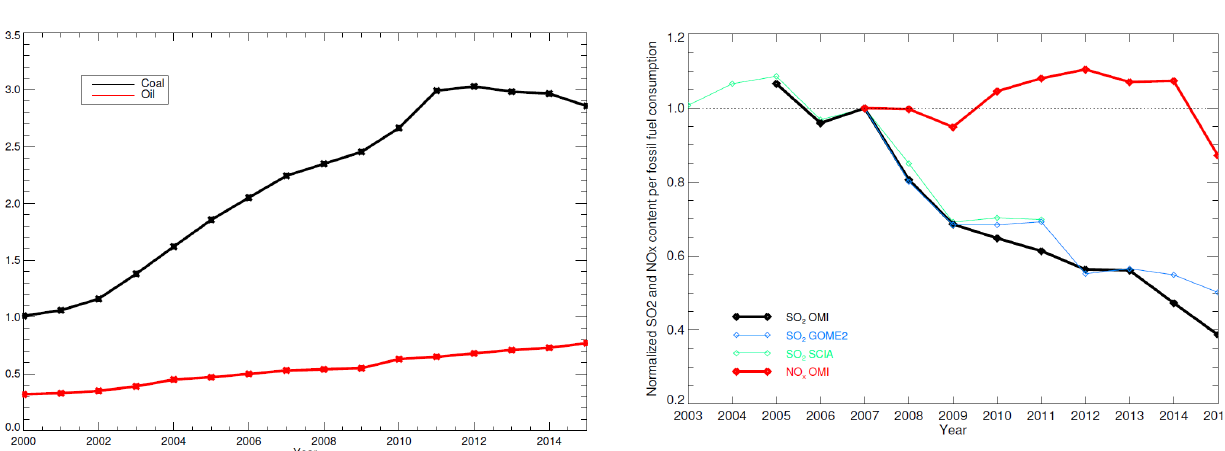
Figure 6. In black the annual coal consumption. In red the annual oil consumption for China.